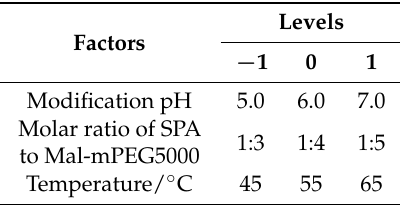
Table 5. Independent variables and levels for central composite design